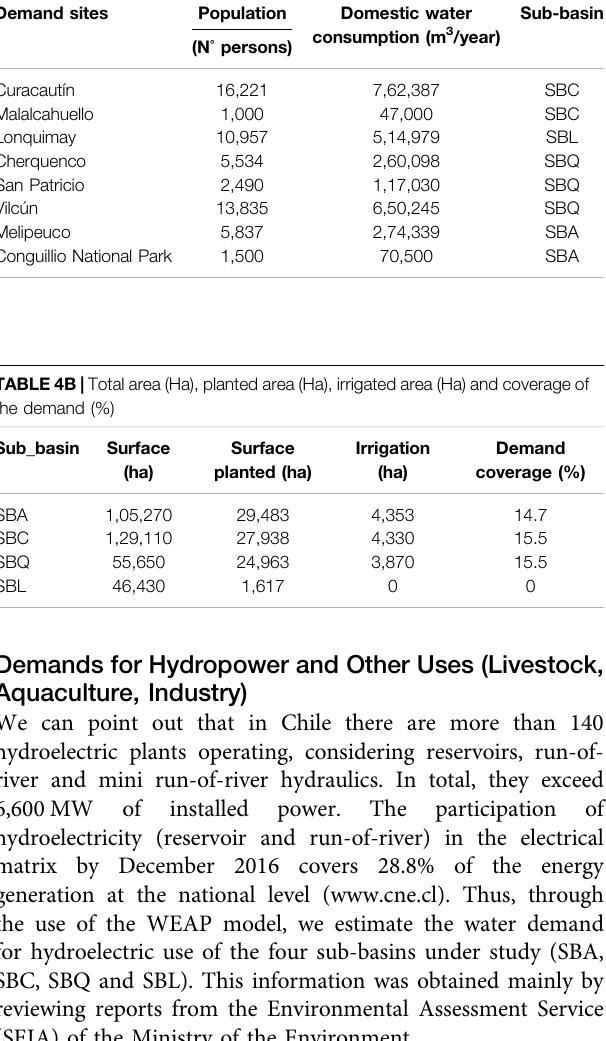
TABLE 4A | Water requirements of each demand site for human consumption (m 3 /yr). Demand sites